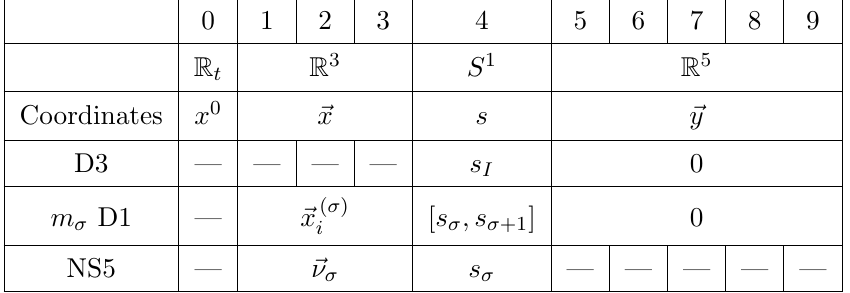
) factor is given by ~v ( (cid:27) ) 1 = diag( ~x ( (cid:27) ) (cid:27)